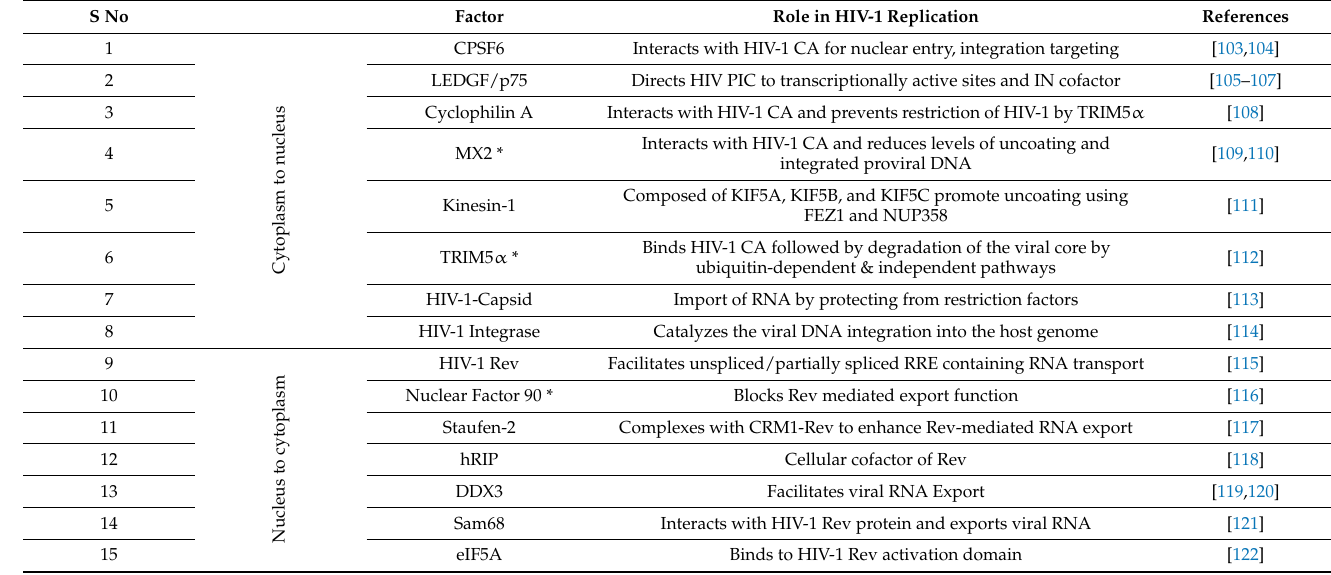
Table 2. List of additional host proteins (other than nucleoporins and NPC-associated proteins) and viral proteins involved in the nucleocytoplasmic trafficking of HIV-1. Some of the listed host proteins act as negative regulators of HIV-1 trafficking